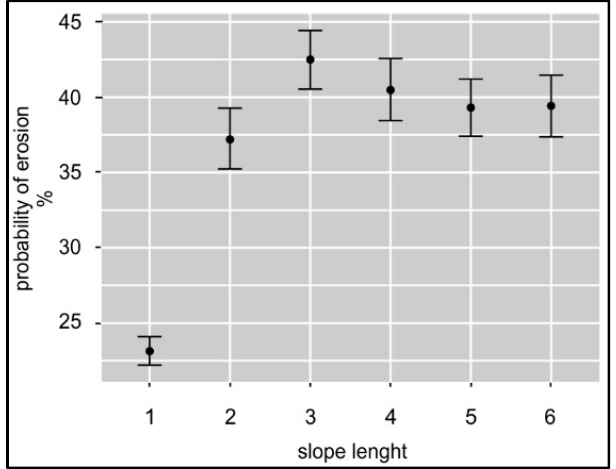
Figure 7. Category of slope length 1 (0–10 m), 2 (10–30 m), 3 (30–60 m), 4 (60–100 m), 5 (100–200 m), 6 (>200 m).